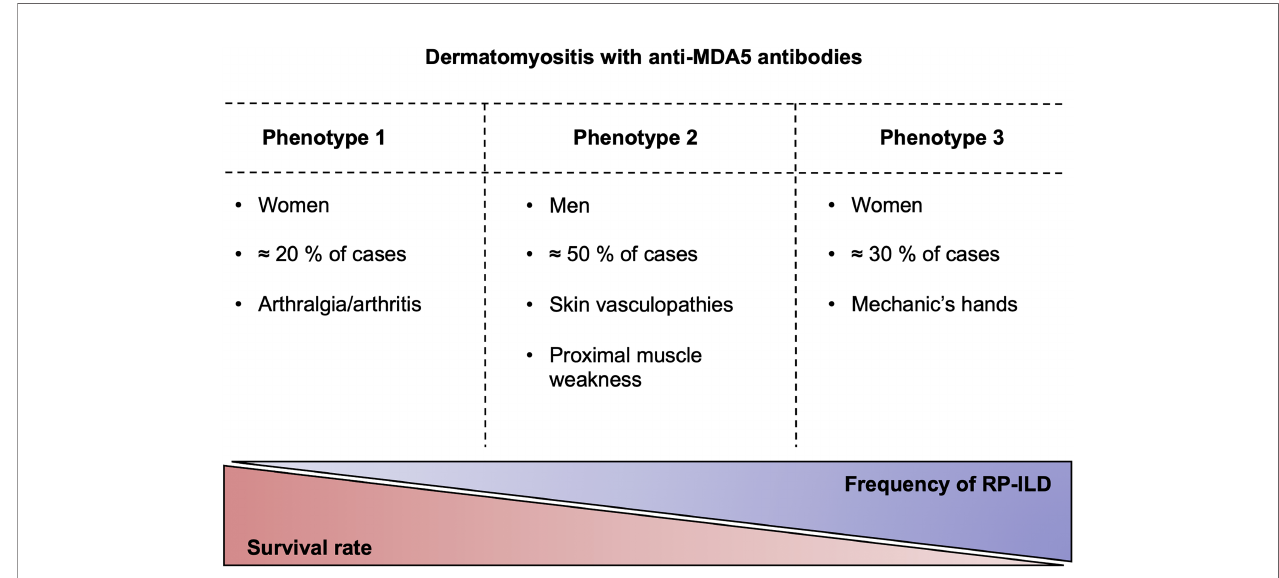
FIGURE 1 | The clinical phenotypes of anti-MDA5 dermatomyositis. Anti-MDA5 dermatomyositis can be divided into three clinical phenotypes with varying degrees of pulmonary damage, which is inversely correlated with the survival. RP-ILD, rapidly progressive interstitial lung